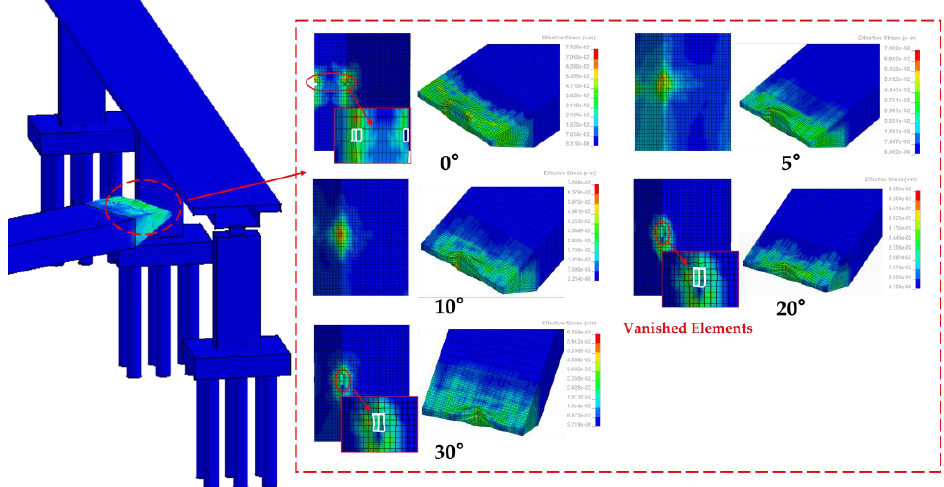
Figure 18. Barge – whole bridge stress nephograms at different barge impact angles.